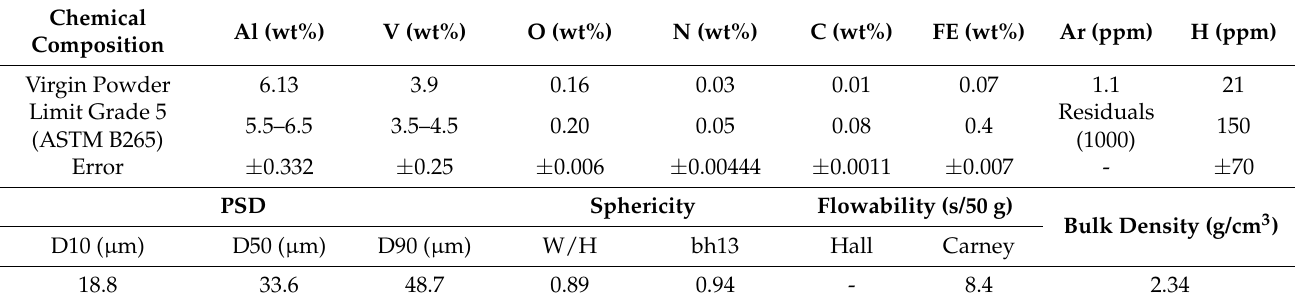
Table 3. Chemical composition, PSD, and morphology of the powder.